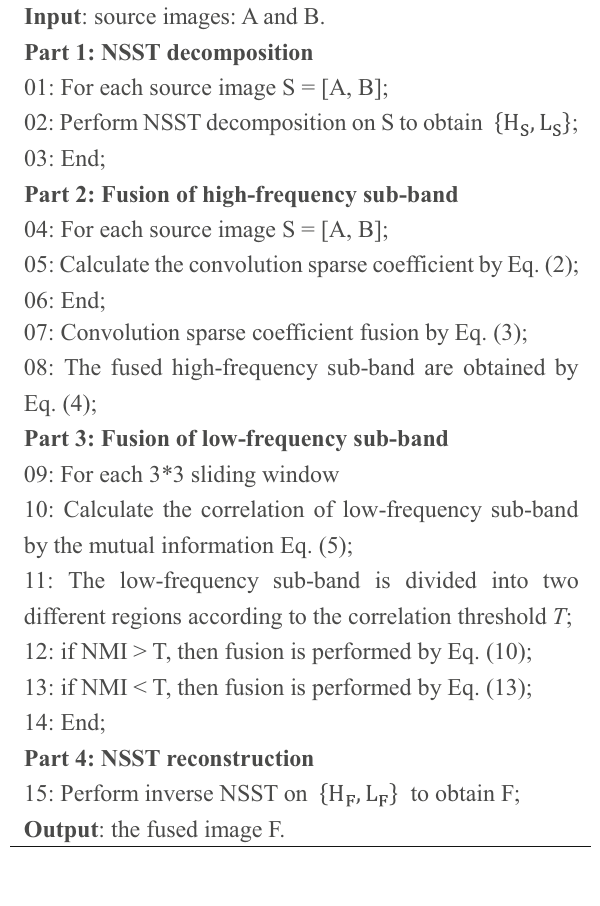
Algorithm 1 Proposed Medical Image Fusion